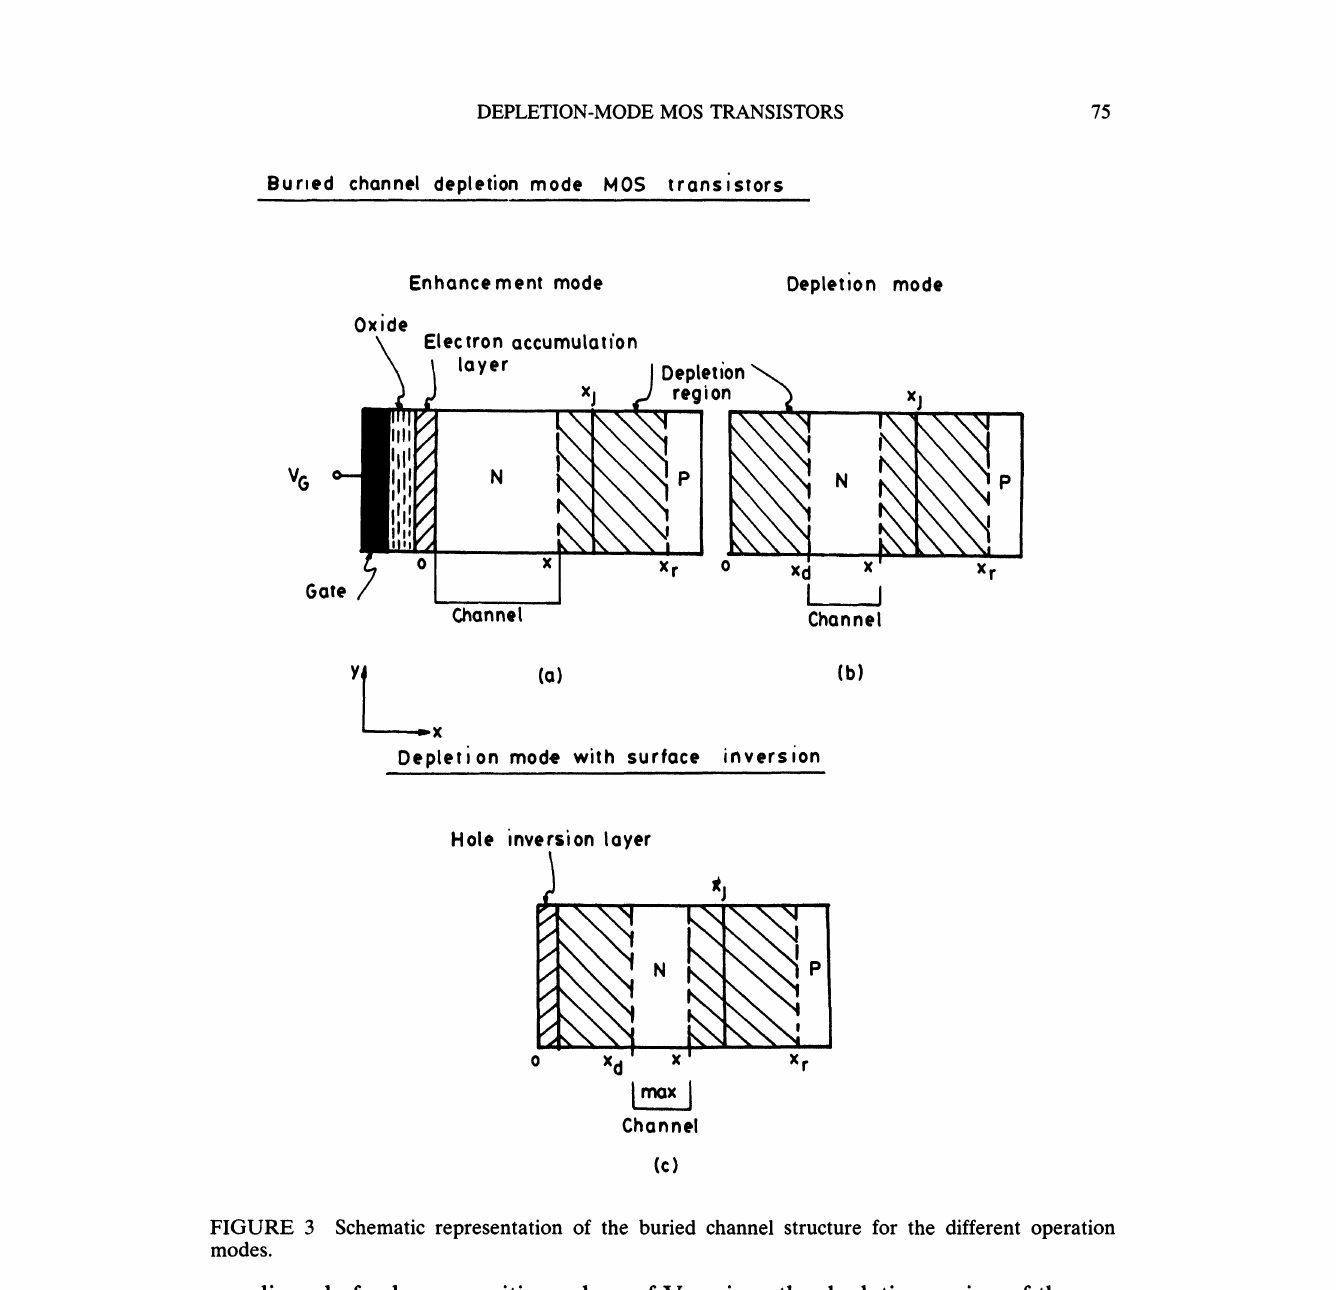
FIGURE 3 Schematic representation of the buried channel structure for the different operation